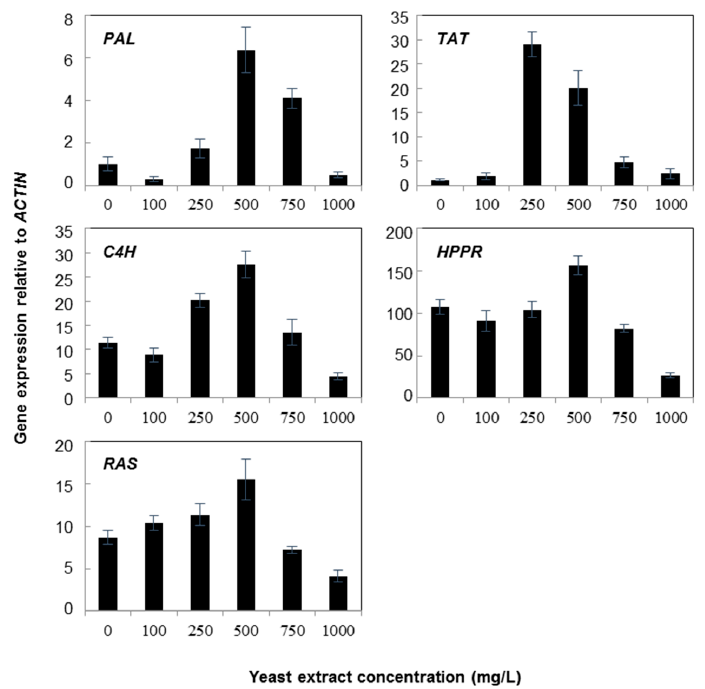
Figure 2. Expression of rosmarinic acid biosynthetic genes in Agastache rugosa calli treated with various concentrations of yeast extract for 72 h. Transcription levels for each gene were analyzed relative to that of ACTIN . Error bars show standard deviation values.